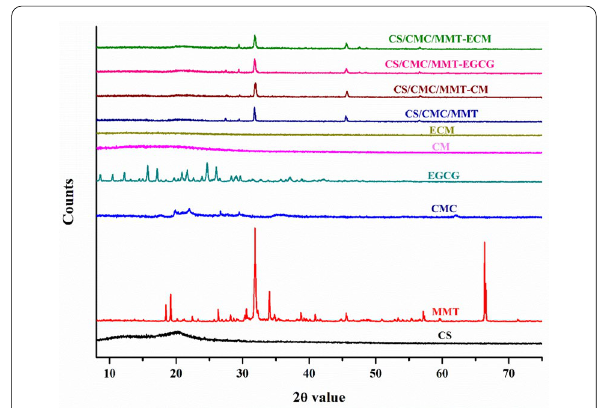
Fig. 4 XRD patterns of CS, CMC, MMT, EGCG, CM, ECM, CS/CMC/ MMT, CS/CMC/MMT‑CM, CS/CMC/MMT‑EGCG and CS/CMC/ MMT‑ECM